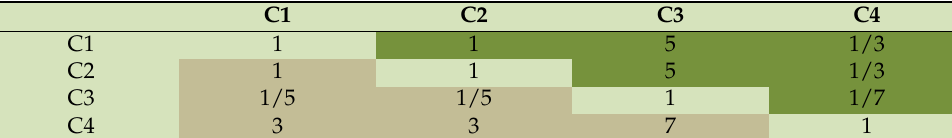
Table 5. Factor pairwise comparison